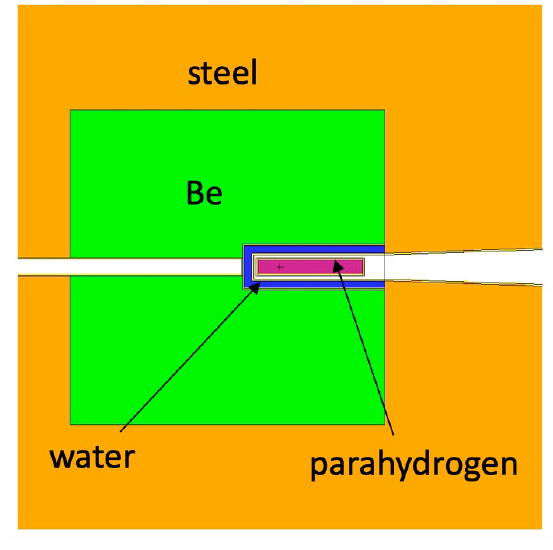
Fig. 1. 1-target geometry configuration.